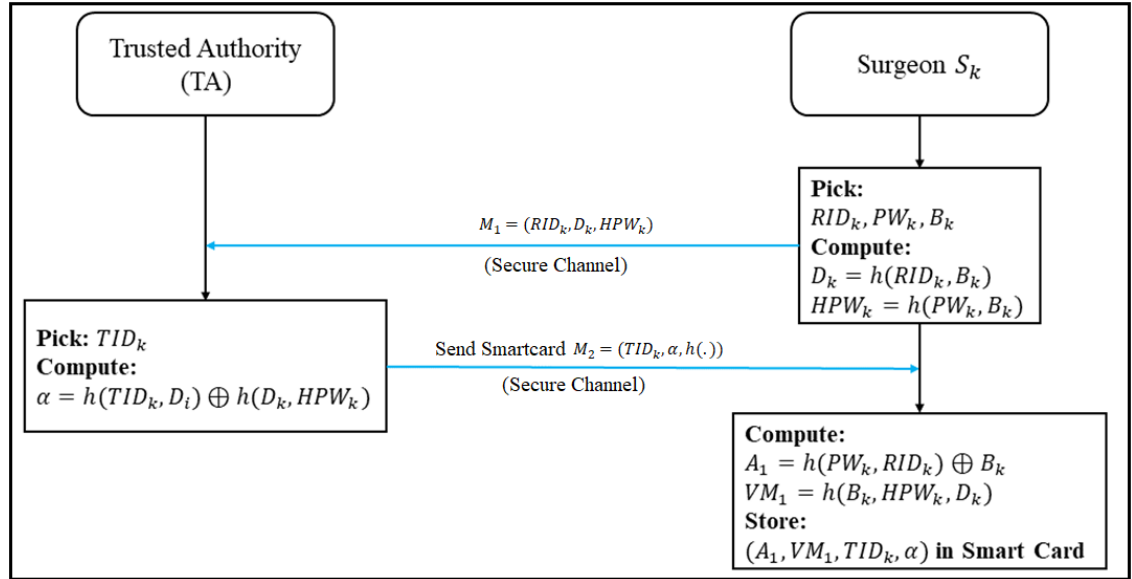
Figure 4. Registration phase of the remote surgeon of the proposed scheme.